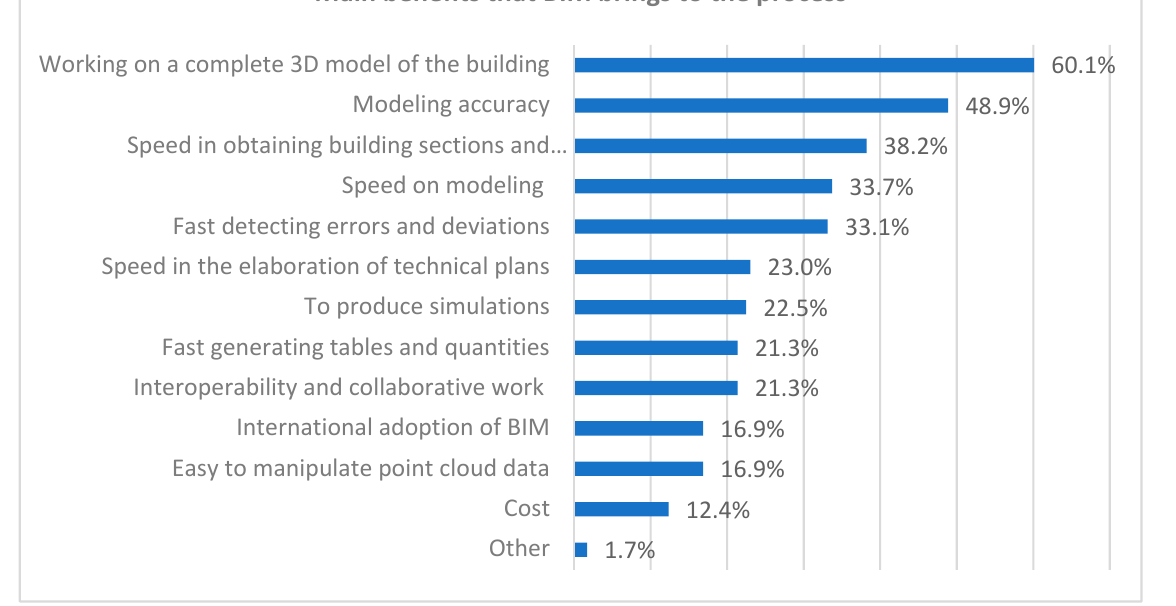
Figure 16. Main benefits that BIM brings to the geometric reconstruction process from point clouds.